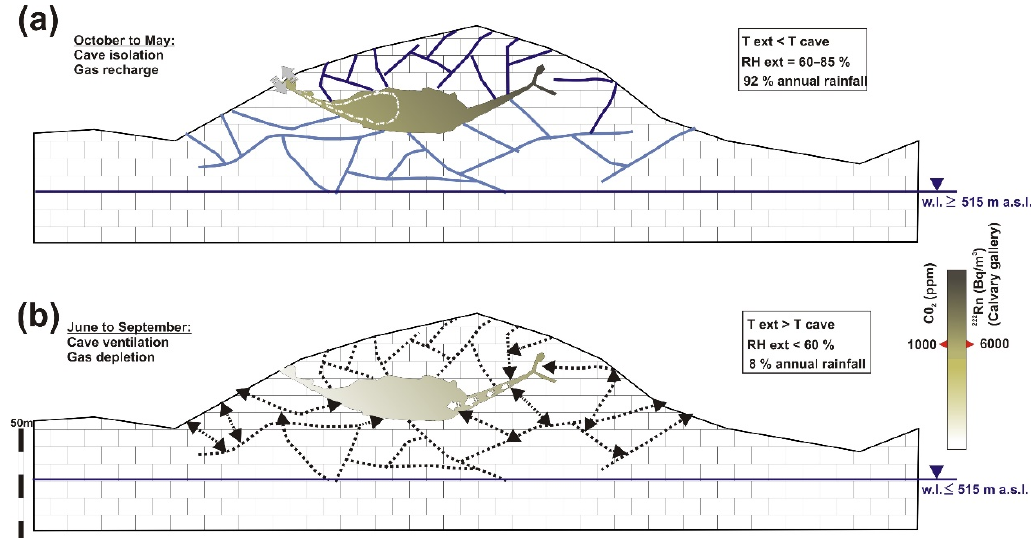
Figure 6. Cross-section of Ardales Cave within the upper vadose zone (heterothermic zone) above the local water table. Two different patterns of cave ventilation are distinguished depending on outdoor weather conditions (see text); ( a ): wet and colder period, and ( b ): drier and warmer period. The idealized network of fissures and conduits network is drawn: ( a ) lower water saturation (blue lines); ( b ) air-filled conduits (dotted lines and arrows).